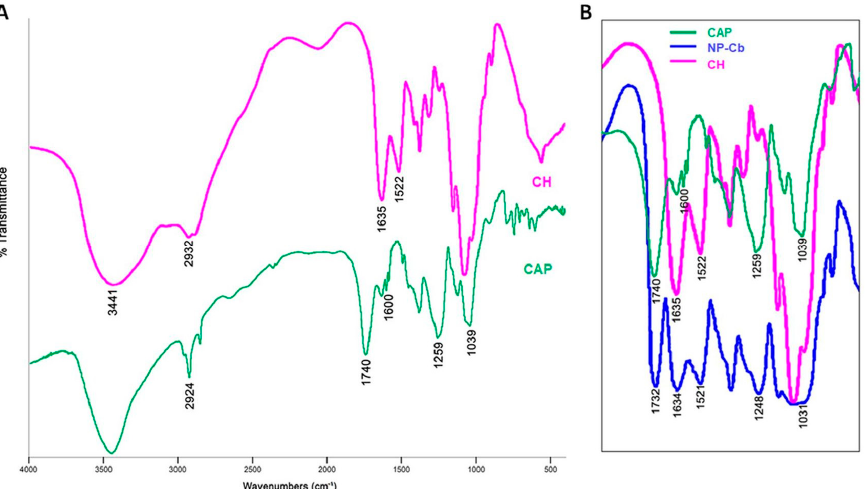
Figure 4. ( A ) FTIR spectra of CAP and CH; ( B ) zoom of the overlap of CAP, CH and NP-Cb spectra in the 1800–1000 cm − 1 region.